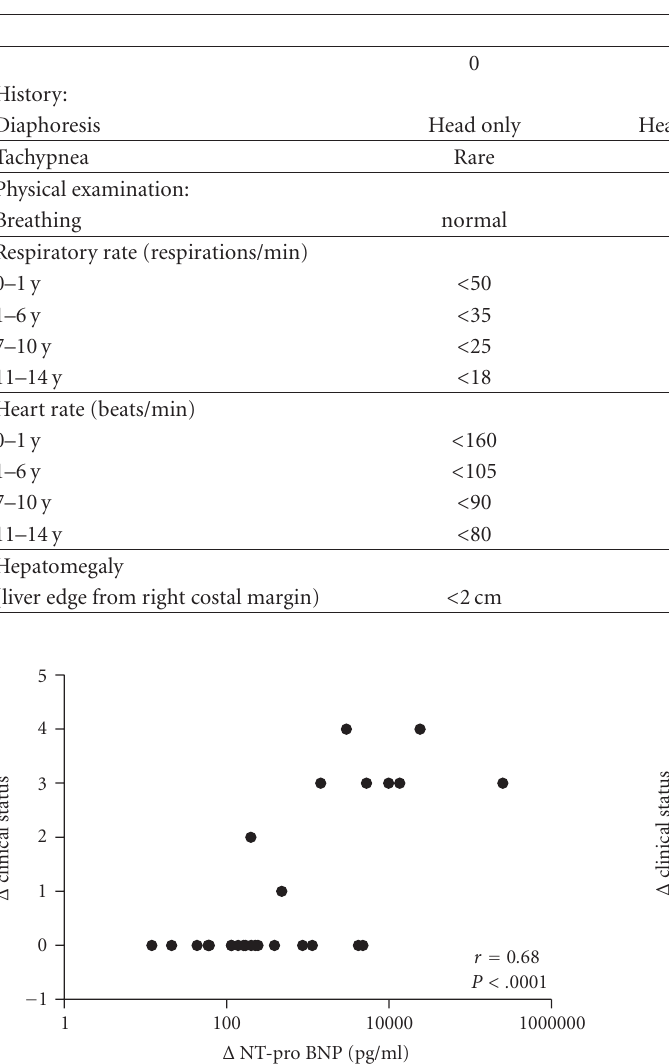
Table 5: Clinical score modified from Ross and Reithmann et al. by Laeer et al.